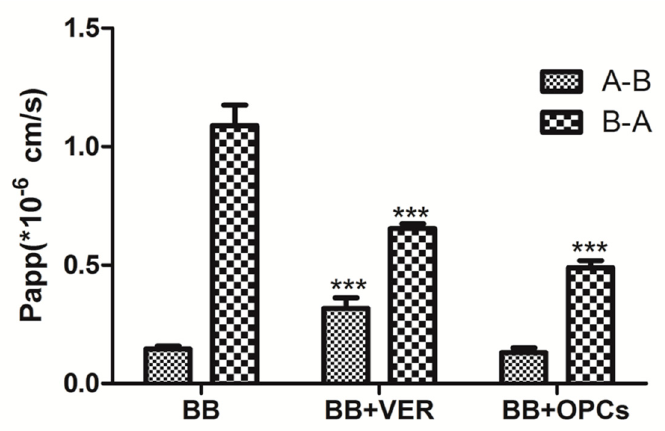
Figure 7. Effects of OPCs and verapamil on the apparent permeability (P app ) of BB across Caco-2 monolayers. The apical to basolateral permeability values PappA-B and basolateral to apical permeability values PappB-A were determined as the slope of the linear portion of each transport-time profile. Data are presented as mean ± SEM of three independent experiments with 2 transwell inserts each. *** p < 0.001 vs. control (BB alone). Table 1. Effects of drugs on the transport of BB across Caco-2 cell monolayers.